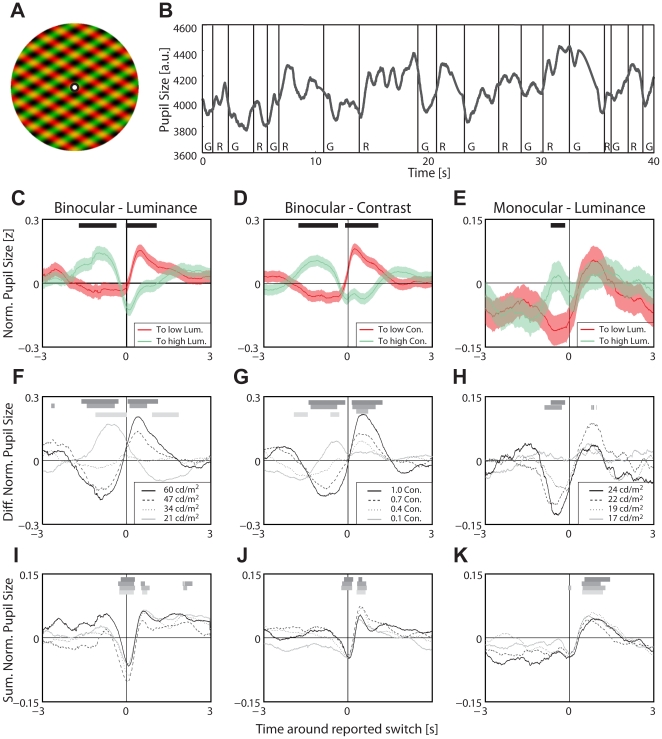
Experiment 1–Pupil size as a function of rivalry dynamics.(A) Example of a monocular rivalry stimulus presented in experiment 1. Fixate on the center dot to observe rivalry. The perceived luminance of each grating fluctuates over time during which one grating has a more dominant luminance than the other. (B) Example of the pupil size as function of time during a single rivalrous trial of one observer. Letters indicate which grating was dominant (R = low luminance red grating, G = high luminance green grating). Black vertical lines are indications of perceptual transitions by the observer. The pupil adapted to the perceived luminance of the dominant percept during rivalry, while physical stimulation was kept constant. (C–E) Average pupil size as function of time relative to the perceptual transitions; red: transition from high to low luminance or contrast, green: transition from low to high luminance or contrast. Light colored patches indicate s.e.m. over all dominance durations. Bars indicate time points were both traces are significantly different at an uncorrected p<0.05. (F–H) Differences between pupil size traces for the two switch directions as a function of time around transitions for all tested luminance and contrast conditions (legend provides luminance/contrast of changed grating, other remains constant, see Methods), means across observers (n = 8); grey-level coded bars indicate time points at which means are different from 0 at p<0.05 . (I–K) Sum of pupil size traces, notation otherwise as in panels F–H. (C–H) For pupil size as a function of normalized relative time between transitions, see Figure S1.